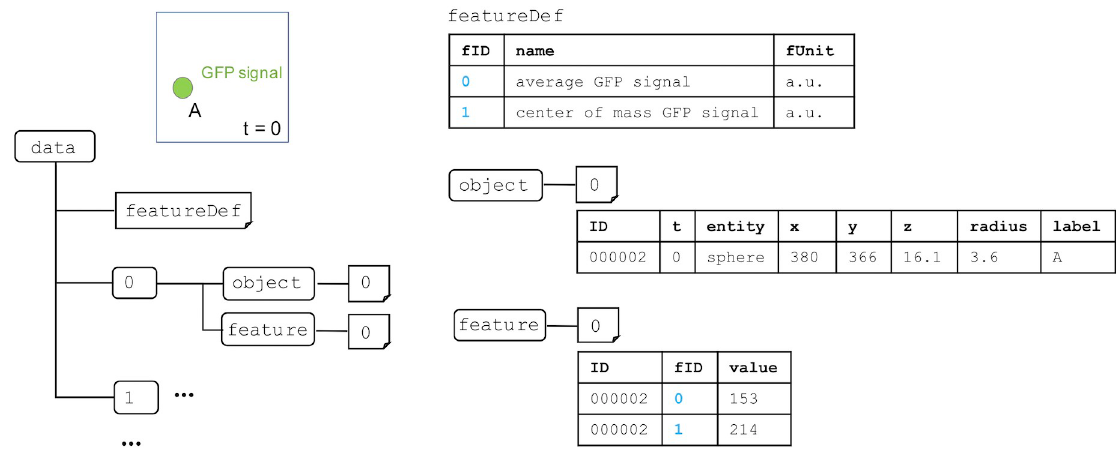
Fig 5. An example of the description of the feature information related to biological objects. The example object is a nucleus expressing green fluorescent protein (GFP) at t = 0 in a time series. The dataset name in feature group corresponds to the identifier (ID) of the biological object. Each row in the dataset has object ID, feature ID (fID, blue), and the feature value. In this example, fID is 0 for total GFP signal or 1 for average GFP signal. Object ID is 0 if the object is a nucleus. Feature value is the fluorescence intensity expressed in a.u. (arbitrary units).